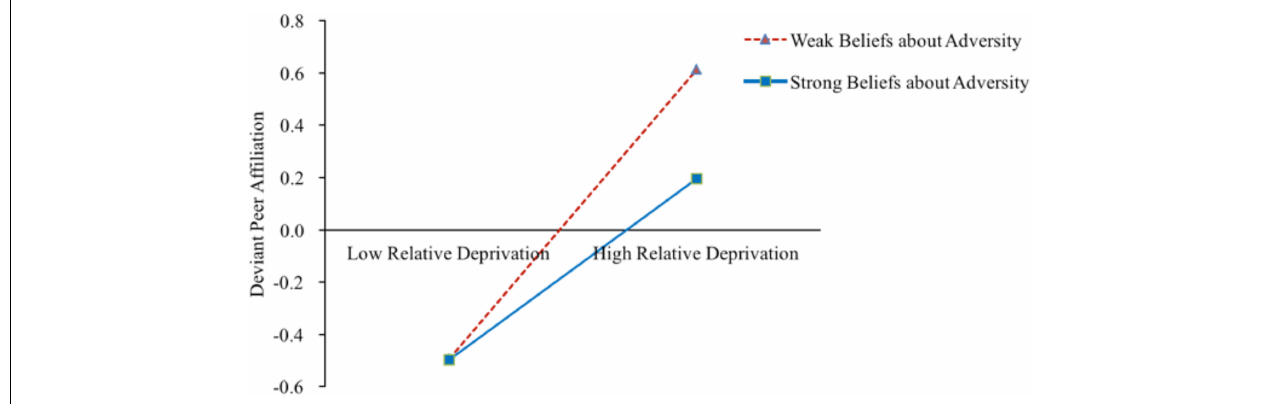
FIGURE 4 | Conditional effect of left-behind children’s deviant peer affiliation as a function of relative deprivation and beliefs about adversity. M ± 1 SD of beliefs about adversity. N = 952.